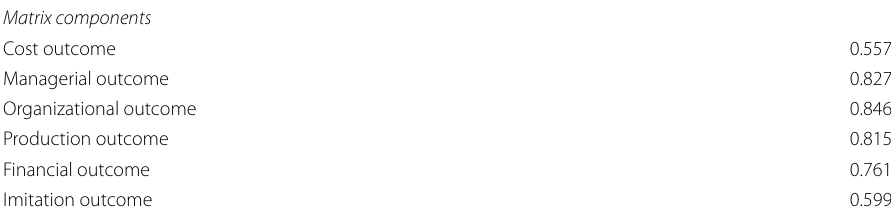
Table 2 Matrix components